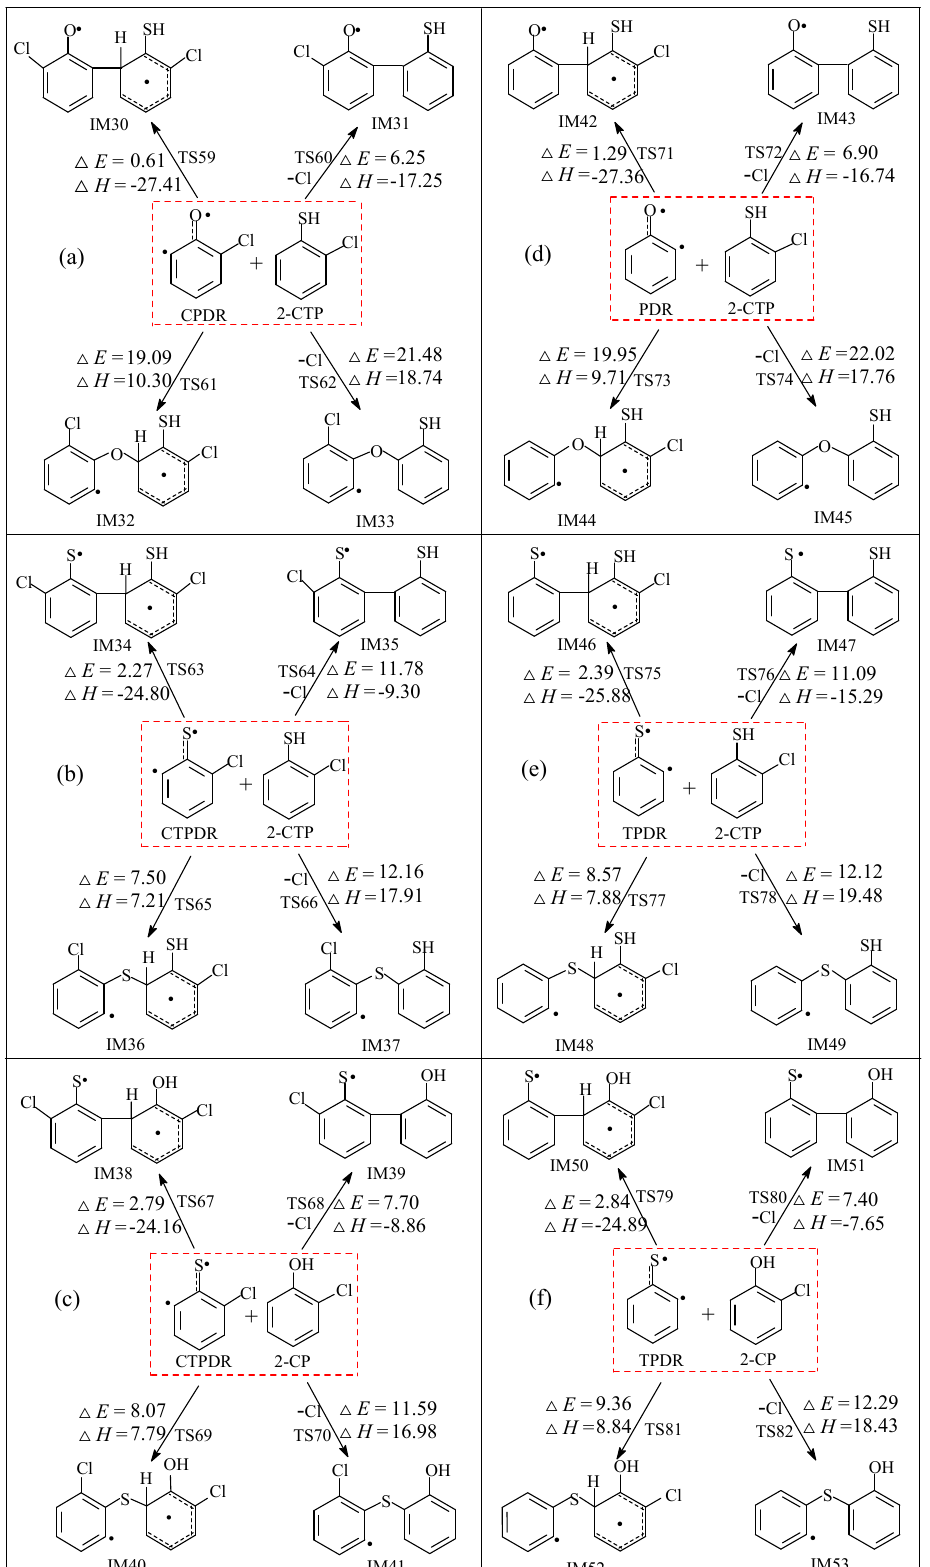
Figure 5. Pre-PCDT/DF formation routes embedded with the potential barriers ∆ E (in kcal/mol) and reaction heats ∆ H (in kcal/mol) from the coupled reactions of CPDR with 2-CTP ( a ), CTPDR with 2-CTP ( b ), CTPDR with 2-CP ( c ), PDR with 2-CTP ( d ), TPDR with 2-CTP ( e ), and TPDR and 2-CP ( f ). ∆ H is calculated at 0 K.